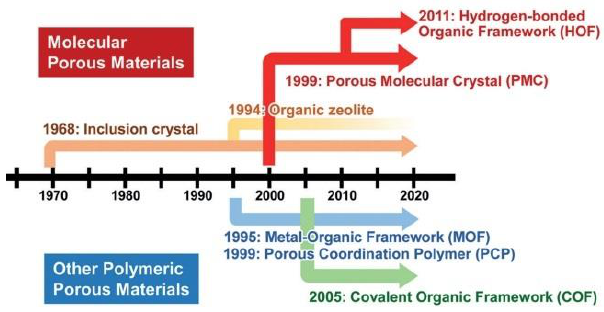
Figure 3. Representative timeline for the development of types of porous molecular materials and related materials. Reproduced with the permission of Wiley-VCH Verlag GmbH & Co. KGaA, Weinheim from [103]. Copyright 2019, John Wiley & Sons.